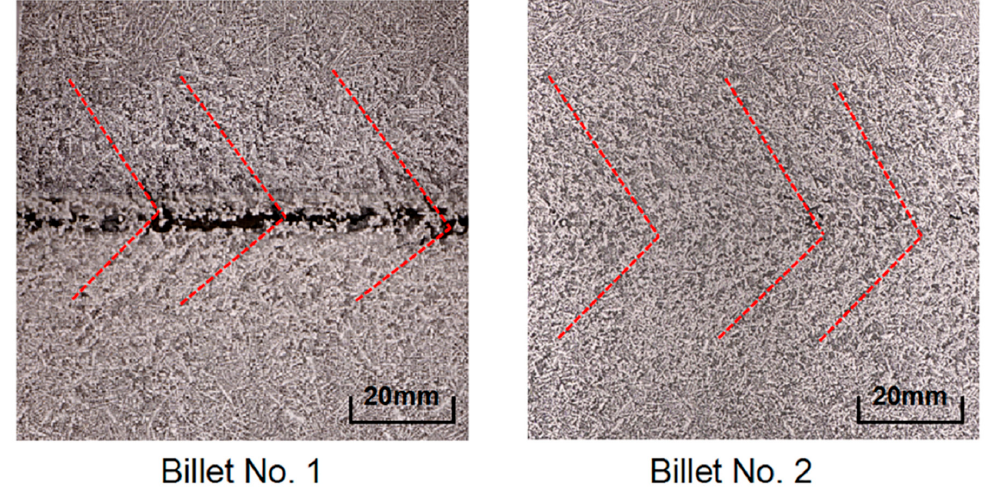
Figure 10. Actual V-shaped segregation angles of billet No. 1 and No. 2. Table 4. Comparison of hysteretic angle and V-shaped segregation angle of billet No. 1 and No. 2.